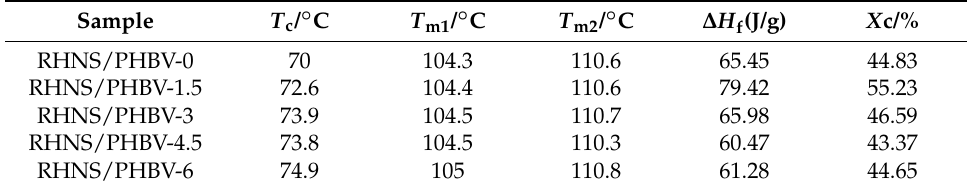
Figure 7. DSC curve of RHNS/PHBV composites: ( a ) cooling crystallization curve and ( b ) heating melting curve. Table 3. The DSC derived data of the RHNS/PHBV